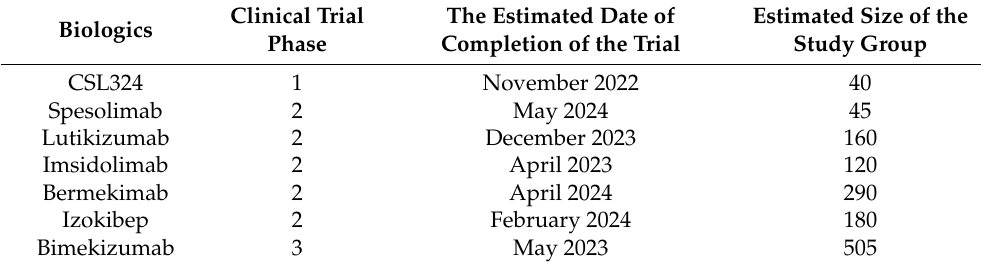
Table 5. A summary of ongoing clinical studies with biologics in